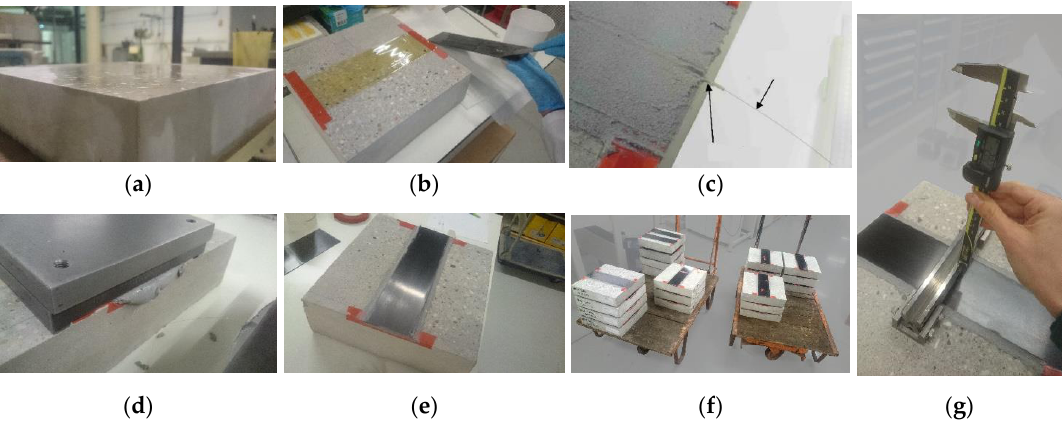
Figure 4. Specimen preparation: ( a ) ground concrete surface; ( b ) application of the adhesive by double-bonding; ( c ) insertion of the OF; ( d ) steel mass for pressing the bond line; ( e ) final aspect of a specimen; ( f ) set of specimens; ( g ) measurement of the thickness of the adhesive layer.